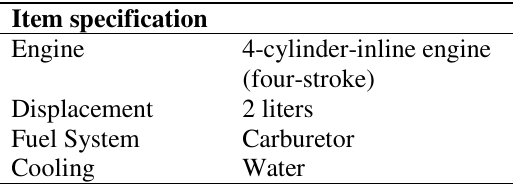
The main technical specifications of the engine.